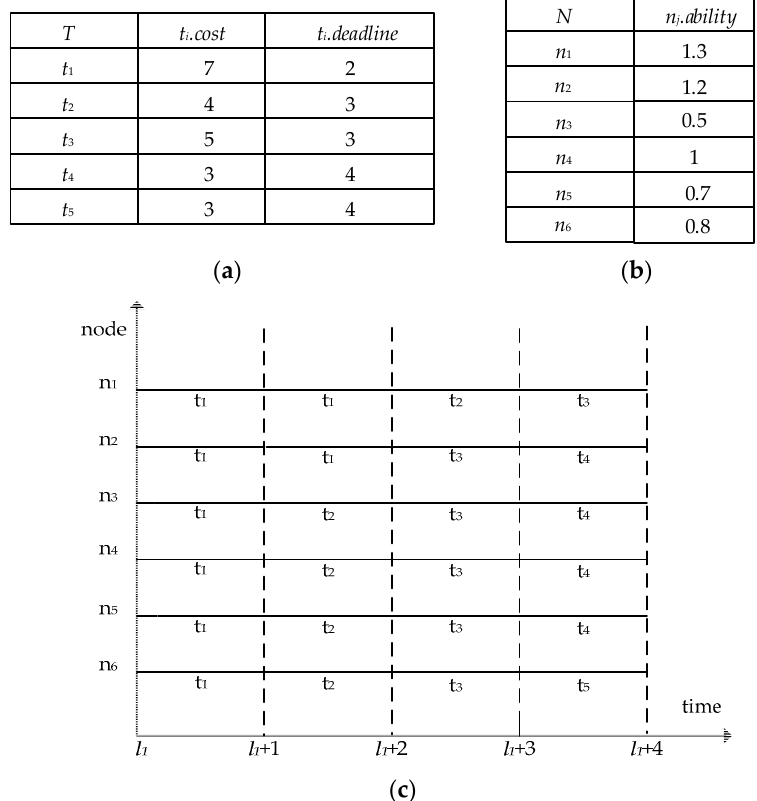
Figure 2. An example of task scheduling at time l 1 . ( a ) List of tasks at time l 1 ; ( b ) list of volunteer nodes at time l 1 ; ( c ) task allocation process at time l 1 .